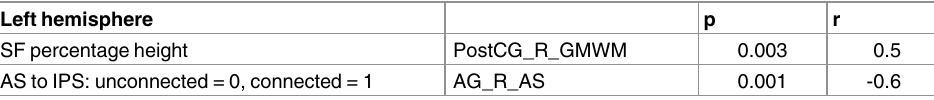
Table 8. Interhemispheric correlation.